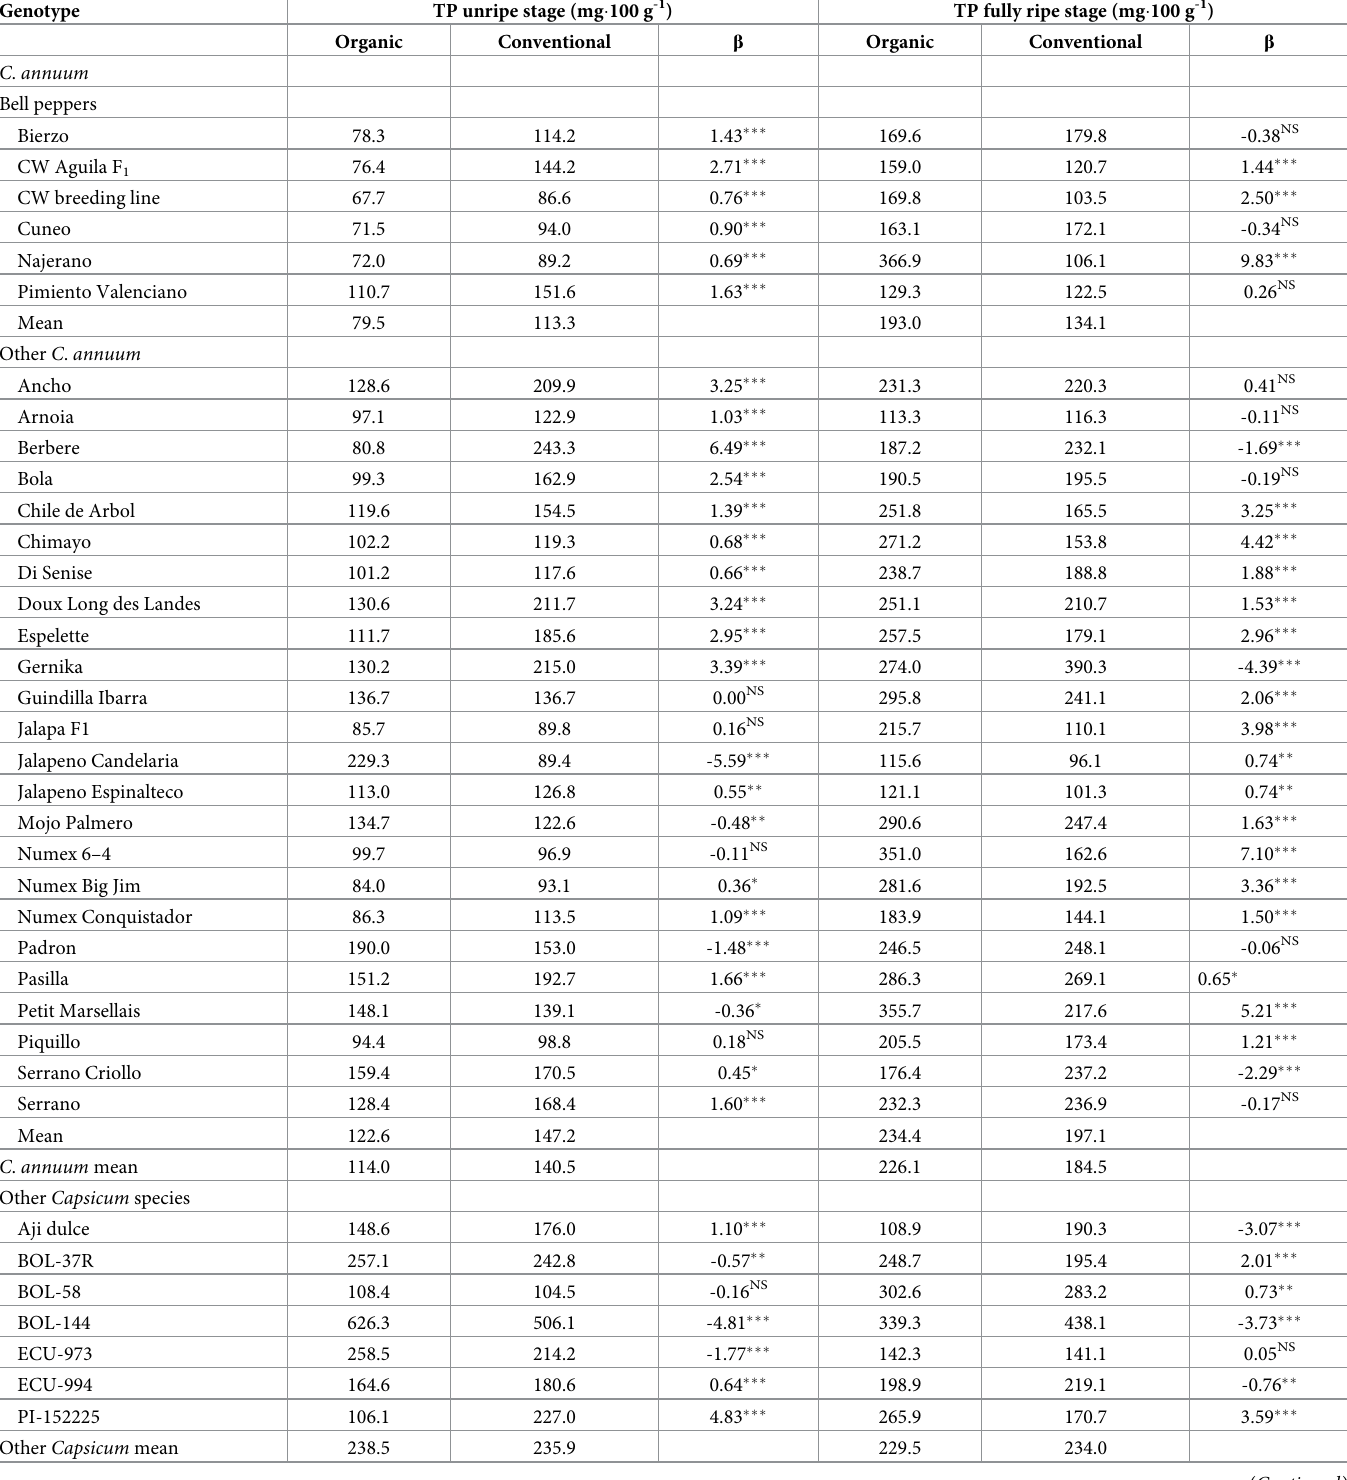
Table 4. Average content in total phenolics content (TP, mg chlorogenic acid equivalents � 100 g -1 fresh weight) estimated in the unripe and fully ripe fruits from the peppers studied, evaluated under organic and conventional conditions and regression coefficient ( β ) based on environmental